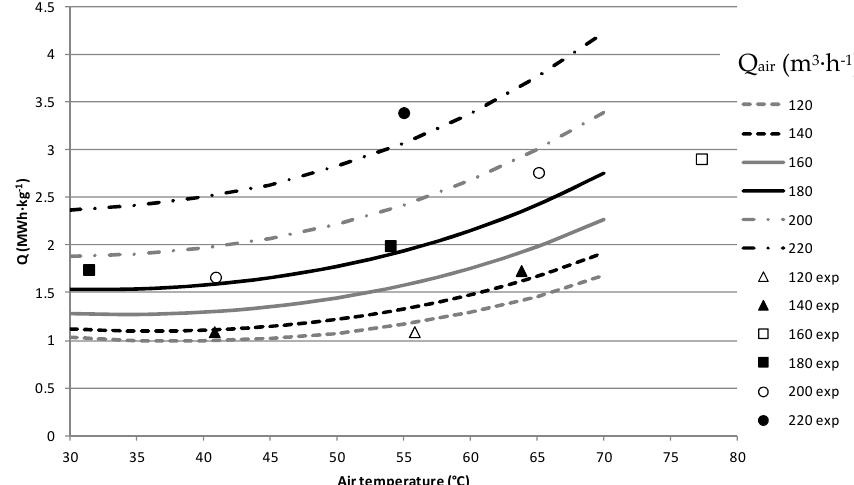
Figure 6. Energy used (experimental = points; DOE equation = lines) for the drying process (per kilogram of evaporated water).